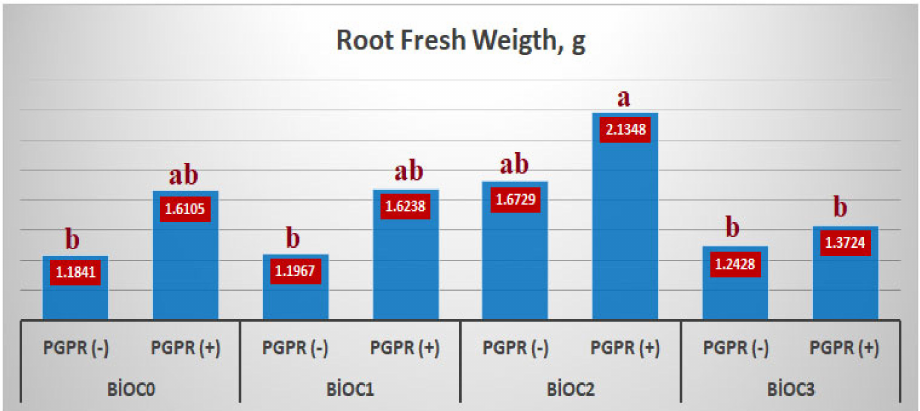
Figure 2. Effect of BxP interaction on root fresh weight (RFW): PGPR(+): Inoculation; PGPR(-): Non-inoculation; BioC 0 : 0% biochar; BioC 1 : 2.5% biochar; BioC 2 : 5% biochar; BioC 3 : 10% biochar; RFW LSD(0.05) : 0.64. Means followed by different letters are statistically different from each other according to Duncan’s Multiple Range test at p ≤